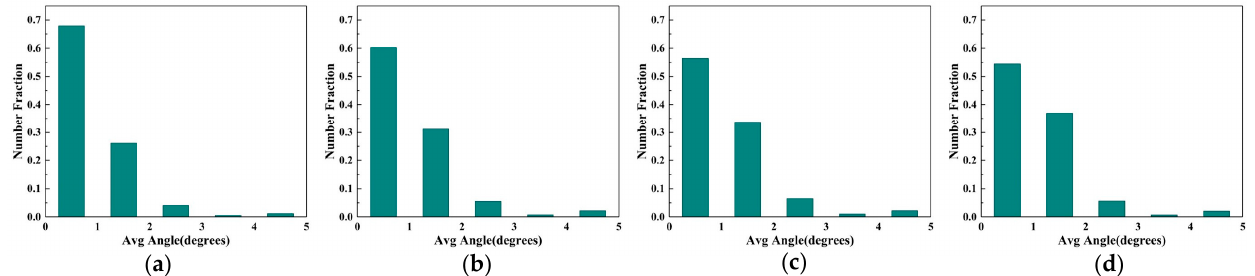
Figure 6. KAM chart of fractured samples at di ff erent temperatures: ( a ) 298 K; ( b ) 213 K; ( c ) 113 K; and ( d ) 20 K.